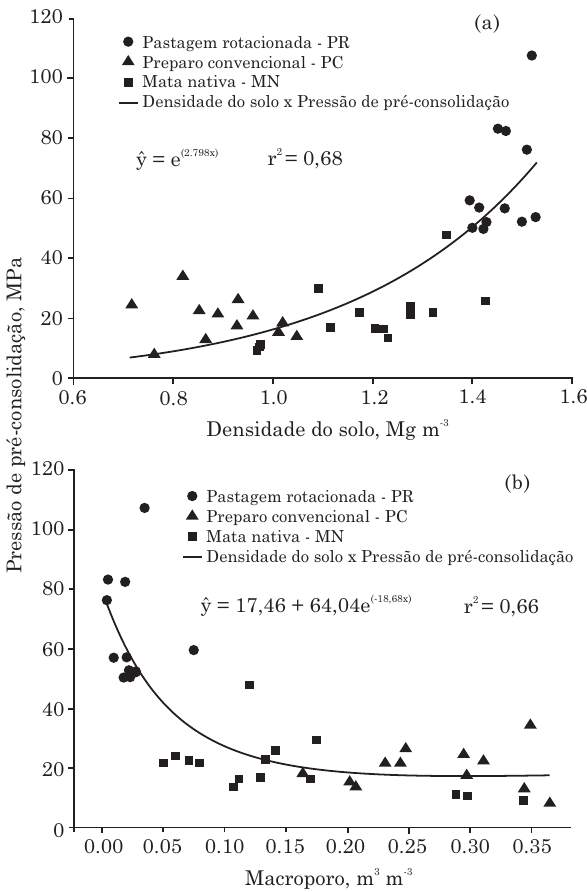
Figura 2. Relação entre a pressão de pré-consolidação e densidade do solo (a) e macroporosidade (b), em três sistemas de uso do